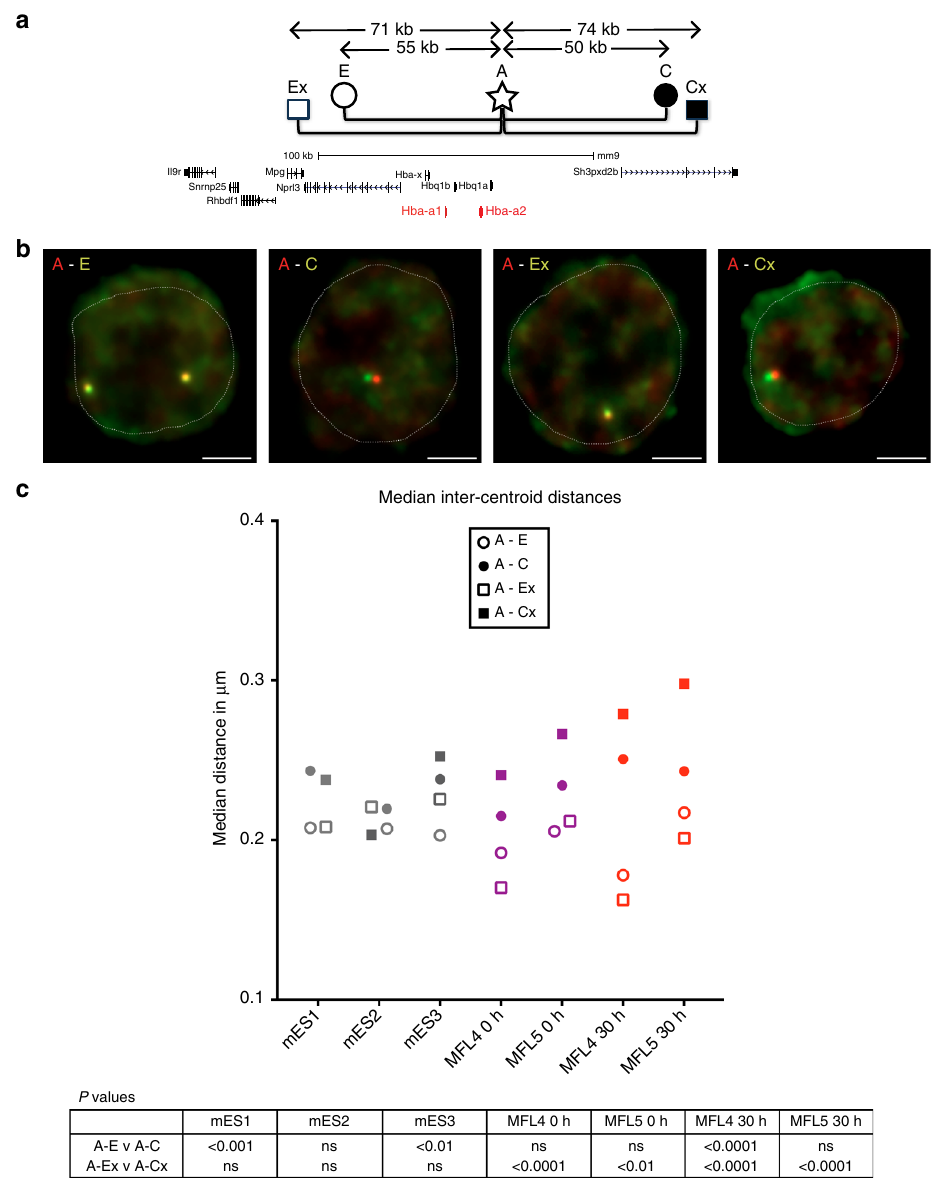
Fig. 4 Proximity measurements at the α -globin locus in mouse WT cells. a Gene map with plasmid FISH probe locations showing the pairwise combinations used to measure inter-probe distances. Using probe A as a point of reference, measurements were made to the domain side (E, Ex) of probe A compared to the control non-interacting side (C, Cx). Genomic distances between midpoints of the probe pairs are shown. b Representative images of RASER-FISH hybridisation signals for the four plasmid probe pairs in MFL 30 h erythroblasts. White dotted line delineates nuclei. Scale bar 2 μ m. c Median inter-centroid distances measured between the four probe pairs in three different cell types, mES1 – 3 (grey), MFL4 – 5 0 h (purple) and MFL4-5 30 h (red). p values, derived by a Kruskal – Wallis test with Dunn ’ s multiple comparisons, are shown. See Supplementary Fig. 4 for full data with statistical analyses. At MFL 0 h and 30 h but not mES, the distance between A and Ex is consistently statistically shorter ( p < 0.0001) than A to